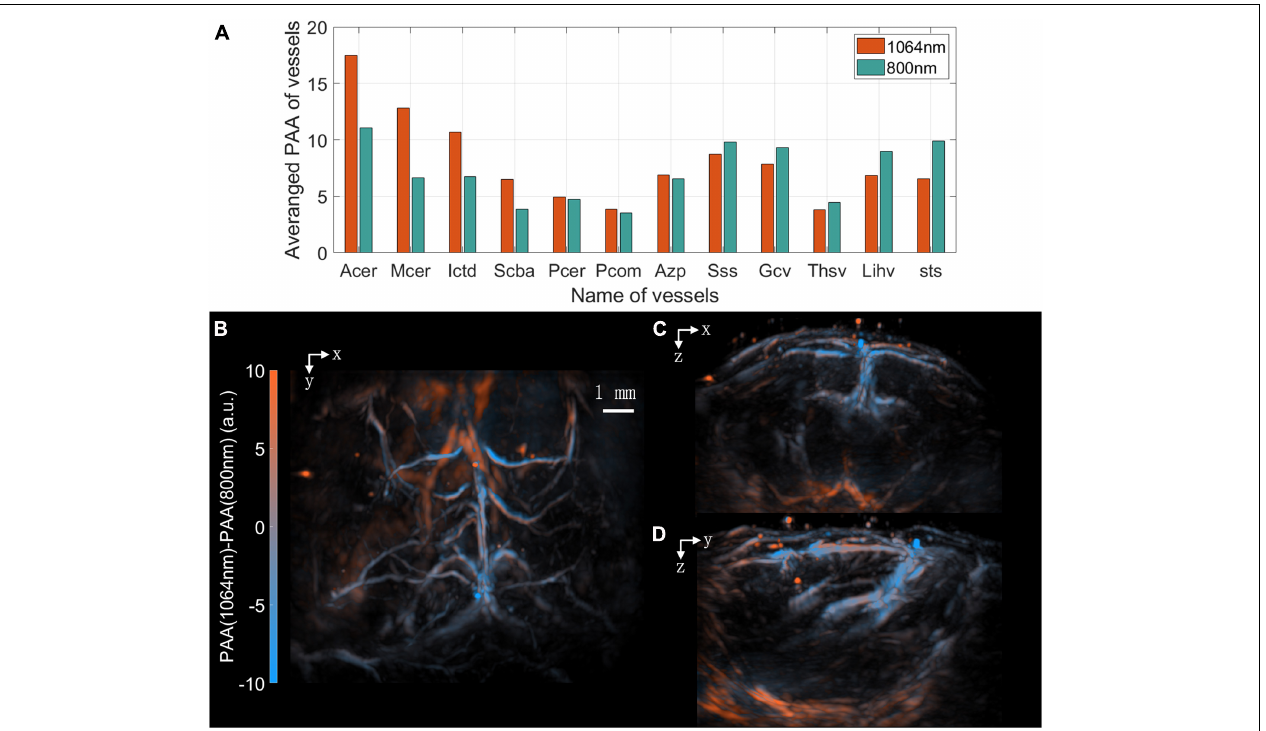
FIGURE 5 | Double wavelength imaging results. (A) Averaged PAA of different vessels. Arteries has larger PAA at 1,064 nm and veins has larger PAA at 800 nm. (B) MIP of the sum of the PA images excited at 1,064 and 800 nm in the x-y plane. (C) MIP in the x-z plane. (D) MIP in the y-z plane. (B–D) Are color coded by the difference of the two PA images excited at 1,064 and 800